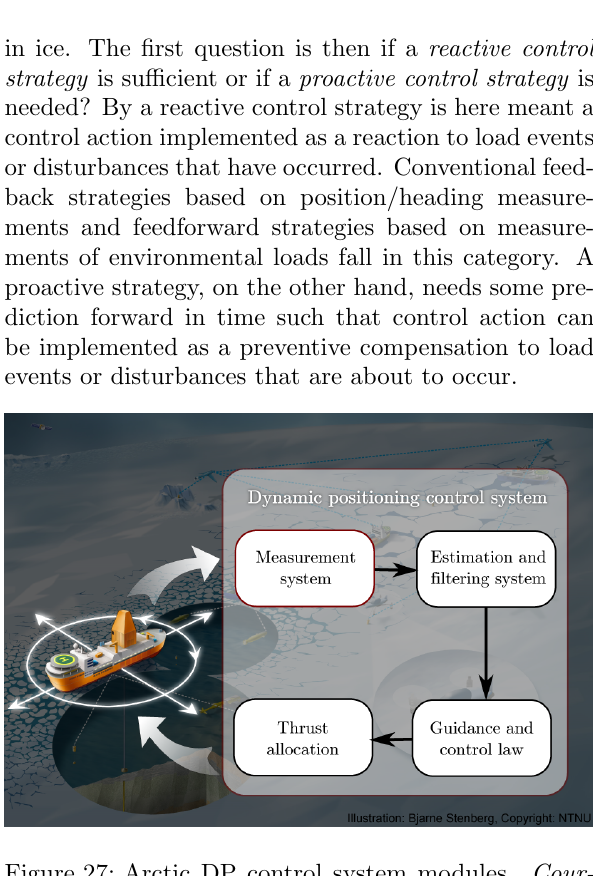
Figure 24: Floe size distribution based on the iden- tified ice floes after the rectangularization process. Courtesy: Zhang et al. (2015)